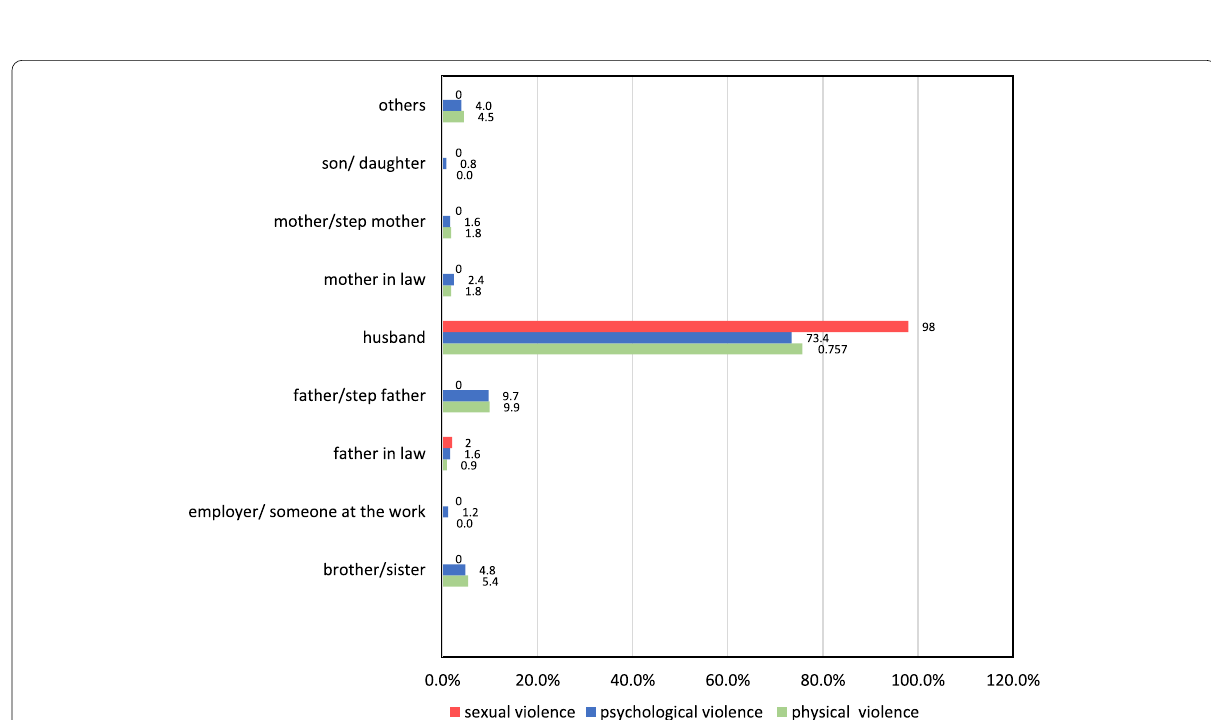
Fig. 3 Percentage of the persons who committed the violence in each type of domestic